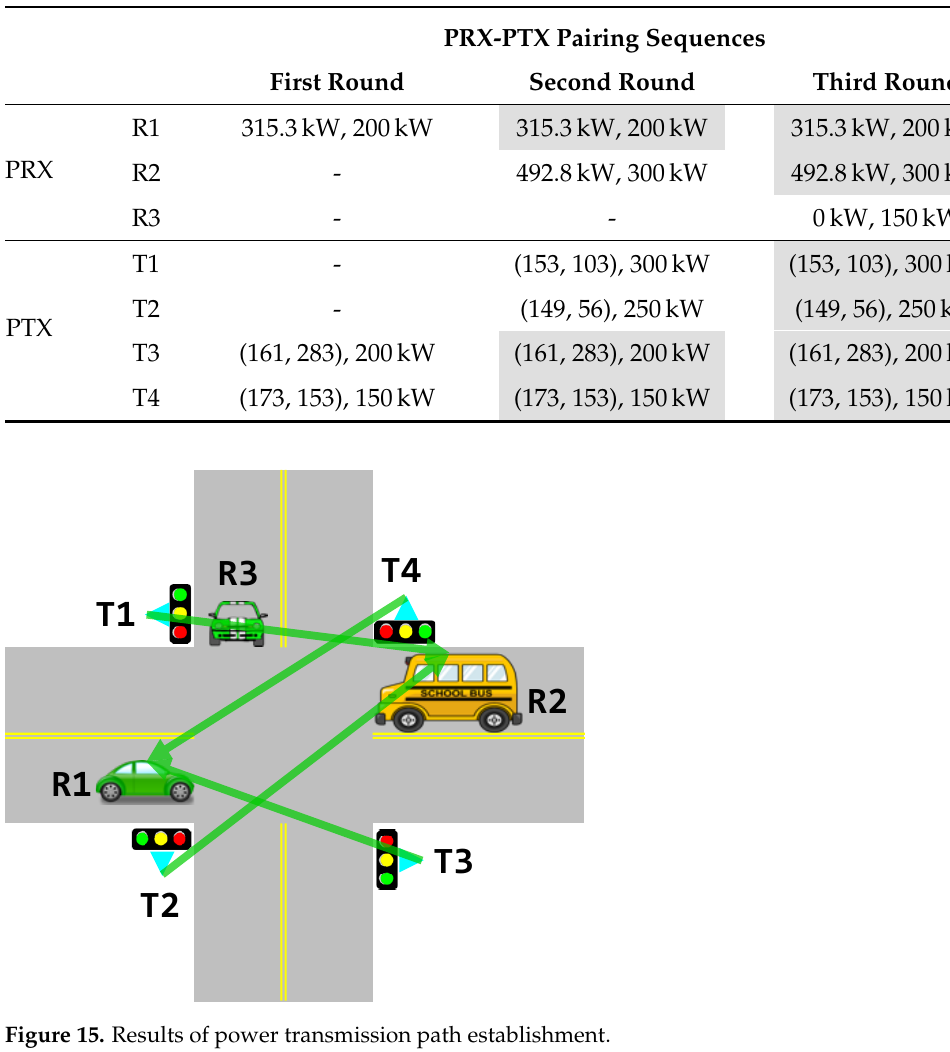
Table 8. Results of WPC using the least power-based PTX selection algorithm.